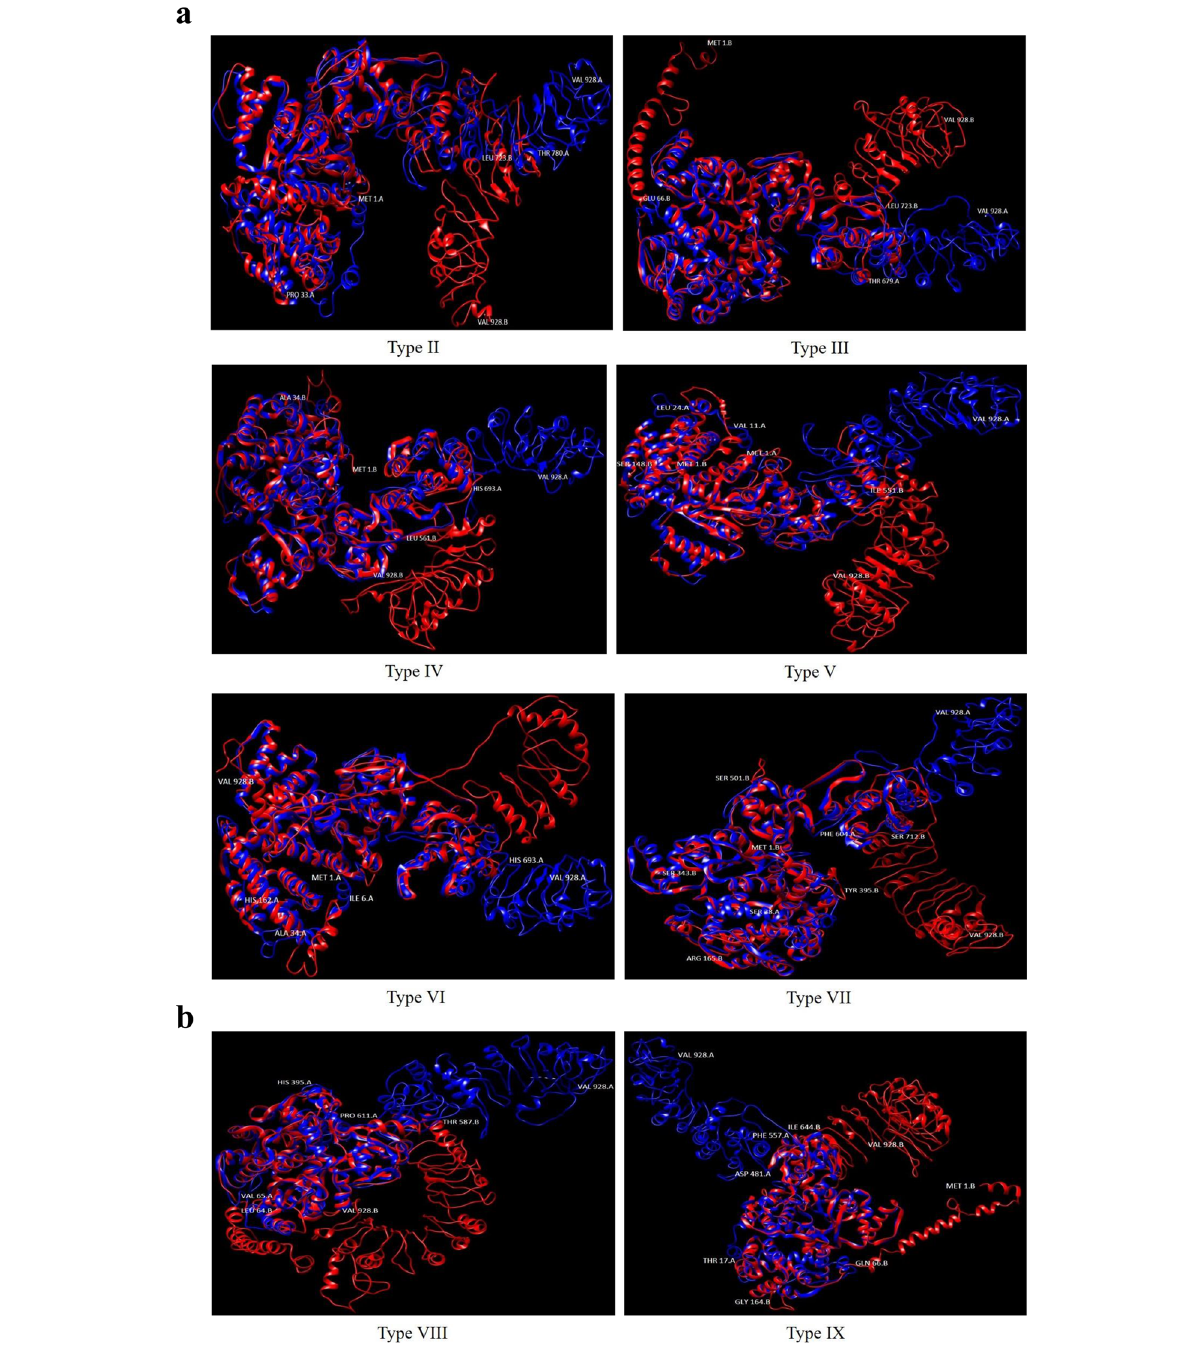
Fig. 2 a Superimposition of wPi-ta with the other eight identified variant allelic types (Types II – VII) in TM-align software. b Superimposition of wPi-ta with the other eight identified variant allelic types (Types VIII and IX) in TM-align